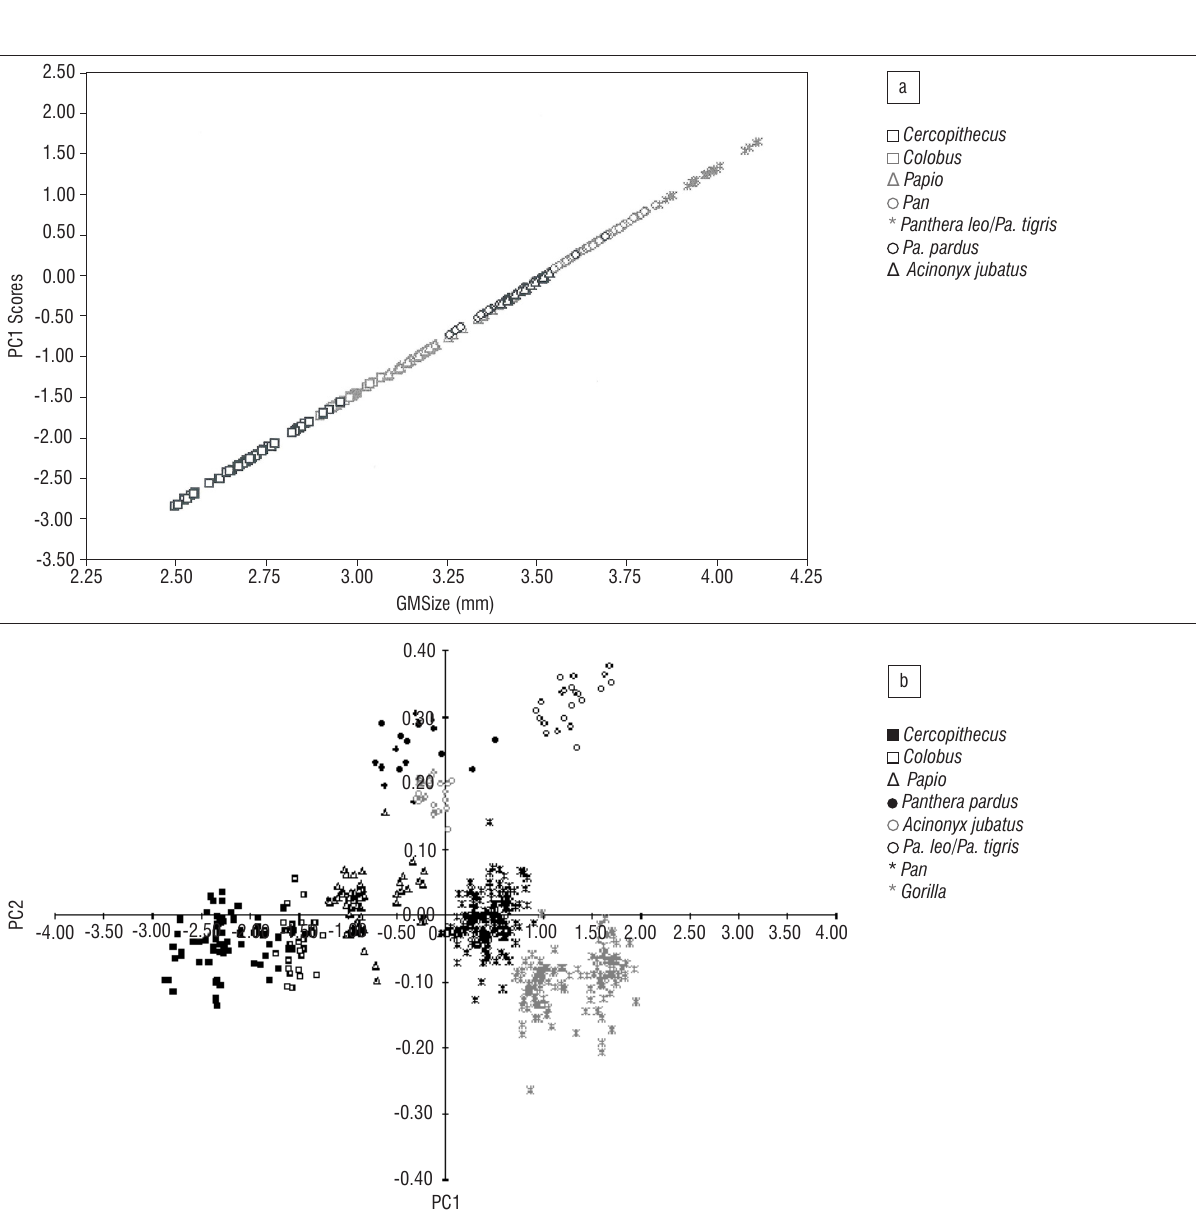
Figure 2: Bivariate scatter plot of (a) PC1 scores ( y -axis) against GMSize and (b) PC2 to PC1 scores of the k =8 postcranial variates in the entire comparative series ( Gorilla excluded for visual